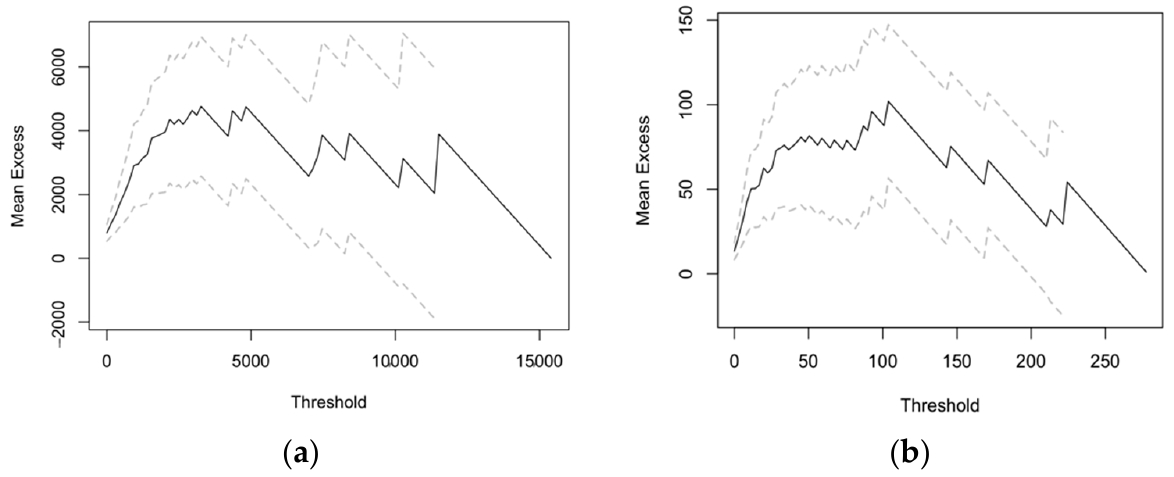
Figure 3. Mean excess plot of ( a ) the houses damaged and ( b ) deaths.